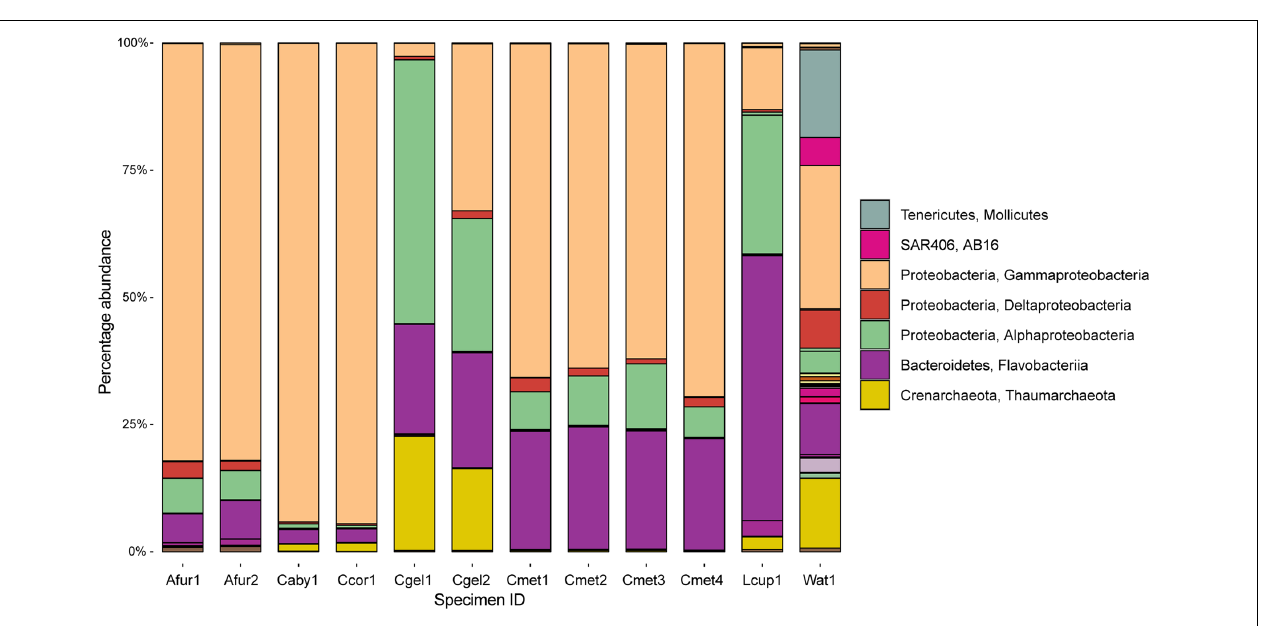
almost absent in A. furcata , C. abyssicola, and C.